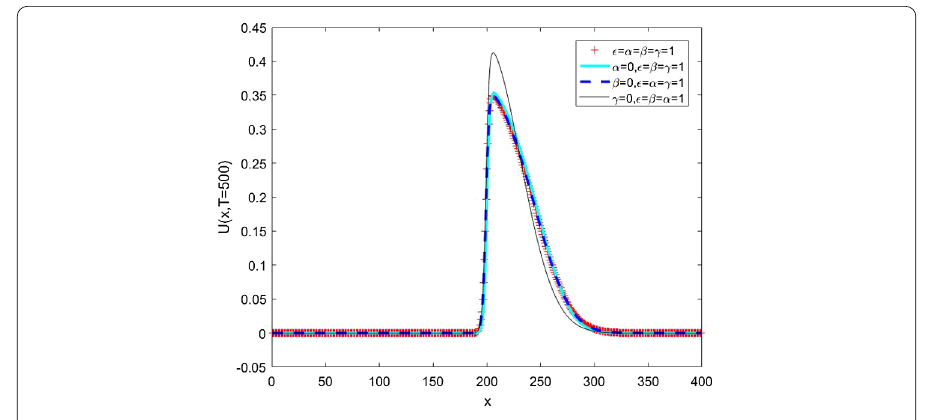
Figure 2 α , β , γ set to 0 or 1 with fixed (cid:4)